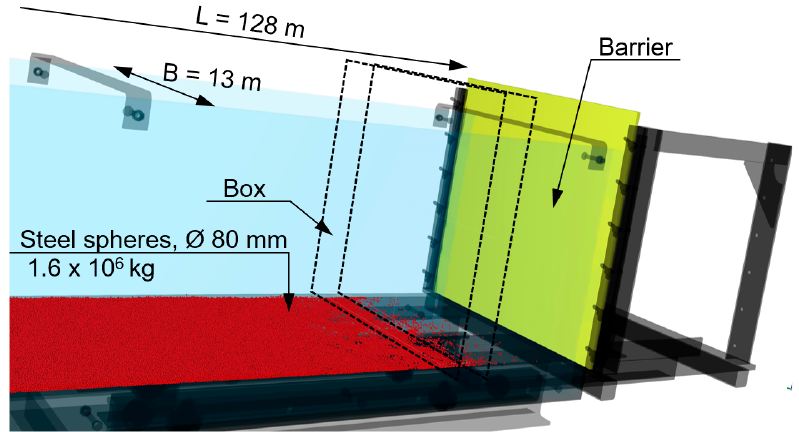
Figure 12. Dimensions of the scaled DEM model with the geometric scale factor λ L = 40, Geometric